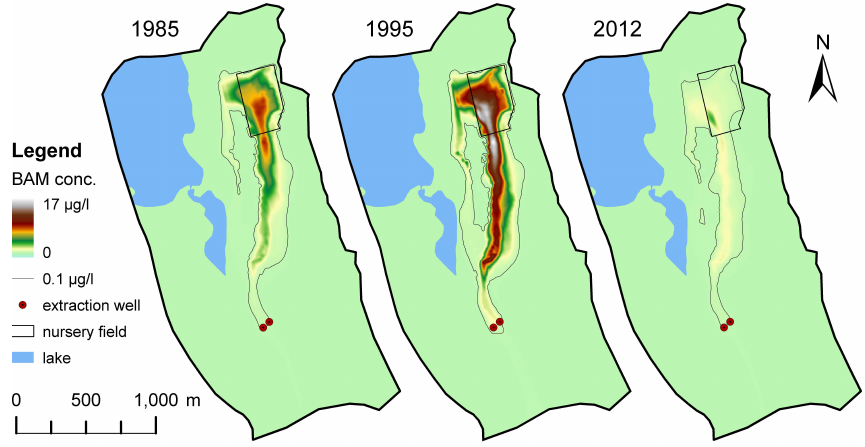
Fig. 11. Simulated BAM plumes in groundwater from 1985, 1995 and 2012. The 0.1µgl − 1 front of the plumes (drinking-water standard) is indicated by black contours.